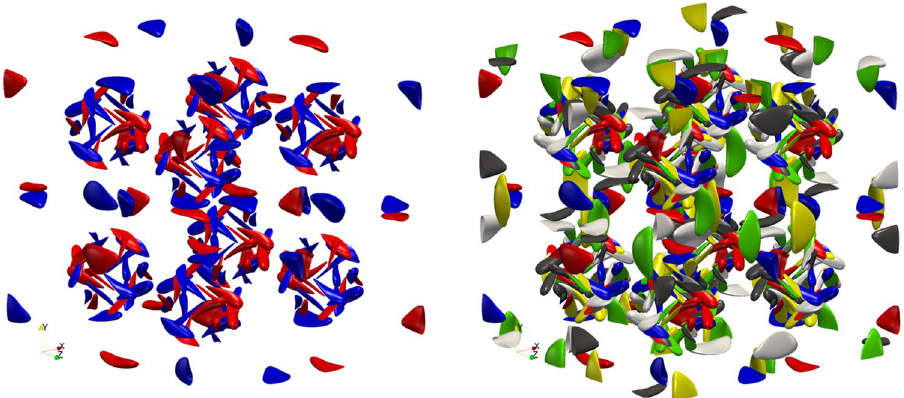
Figure 1. An illustration of the difference between sparseness of the super-level sets of the individual components and the full vectorial super-level set. The figure on the left depicts the super-level sets of the positive and the negative parts of the first component of the vorticity field, while the figure on the right—the union of the six individual super-level sets—corresponds to the super-level set of the vorticity magnitude. Obtained from the Kida simulation.